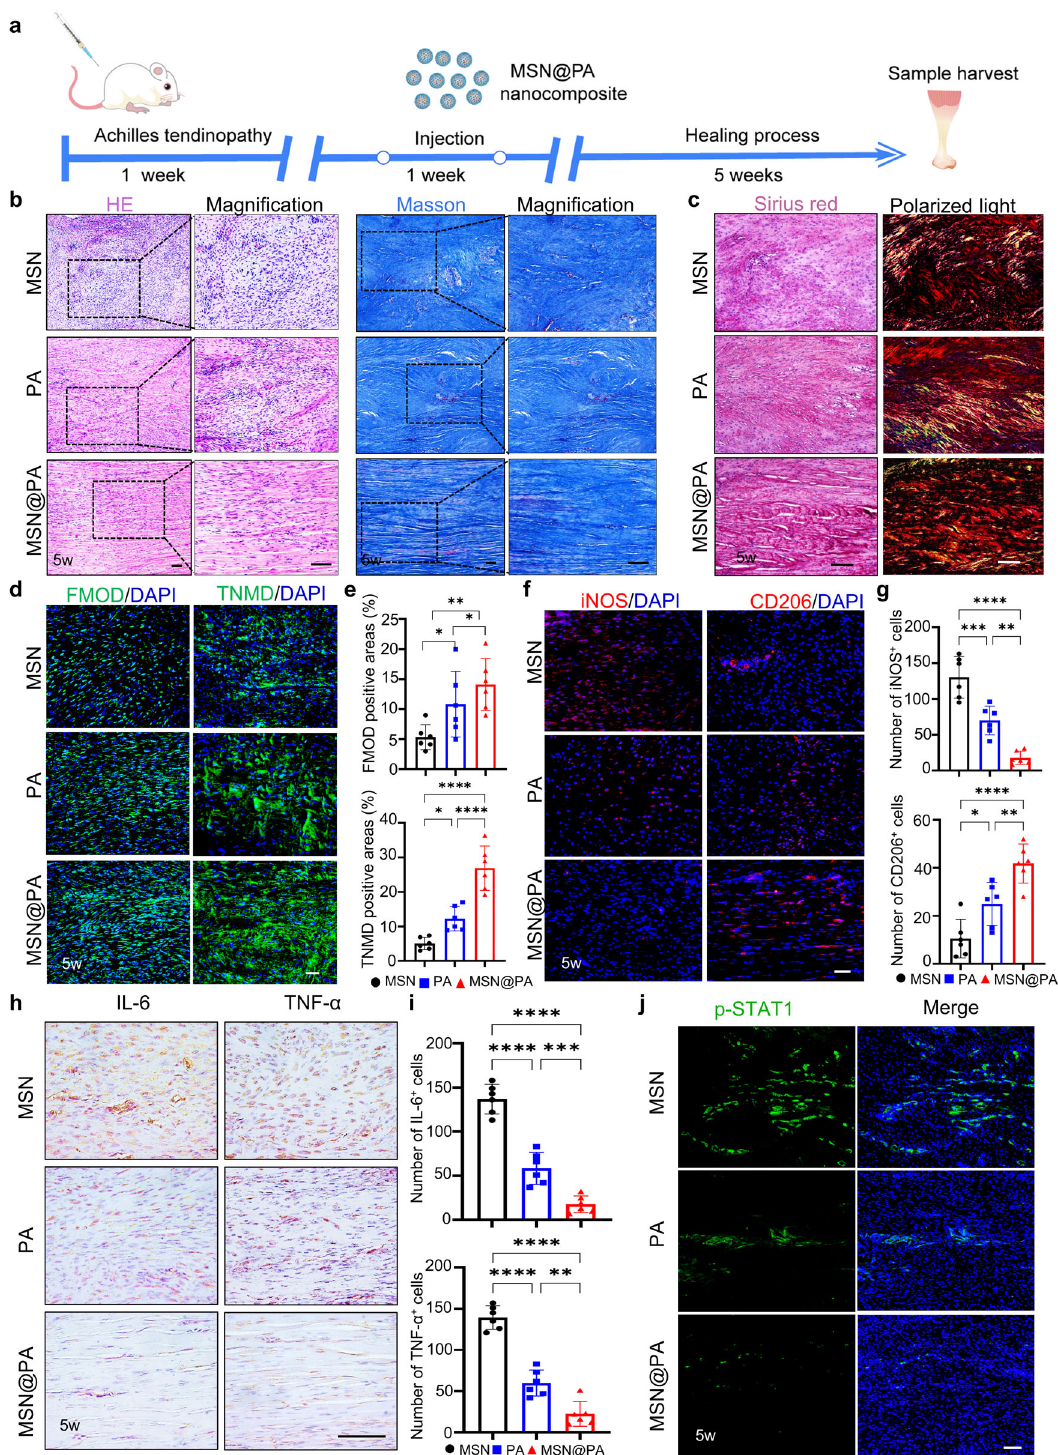
Fig. 5 Local injection of MSN@PA with reduced frequency promotes recovery of tendinopathy by boosting macrophage polarization. a Scheme of local delivery design. b HE and Masson ’ s trichrome stainings of neo-tendons from MSNs, PA, and MSN@PA groups at 5 weeks. Scale bar, 100 μ m. c Representative Sirius red staining and polarized light images of repaired tendons from the PBS and PA groups at 5 weeks. Scale bar, 100 μ m. d Immuno fl uorescence staining of FMOD and TNMD in repaired tendons from the PBS and PA groups at 5 weeks. Scale bar, 100 μ m. e Semi-quanti fi cation of d . f Immuno fl uorescence staining of iNOS and CD206 in repaired tendons from the PBS and PA groups at 5 weeks. Scale bar, 100 μ m. g Semi-quanti fi cation of f . h Immunohistochemical staining of IL-6 and TNF- α in repaired tendons from PBS and PA groups at 5 weeks. Scale bar, 100 μ m. i Semi-quanti fi cation of h . j Immuno fl uorescence staining of p-STAT1 in repaired tendons from the PBS and PA groups at 5 weeks. Scale bar, 100 μ m. Data are presented as mean ± SD. * p < 0.05, ** p < 0.01, *** p < 0.001 and **** p < 0.0001, n =